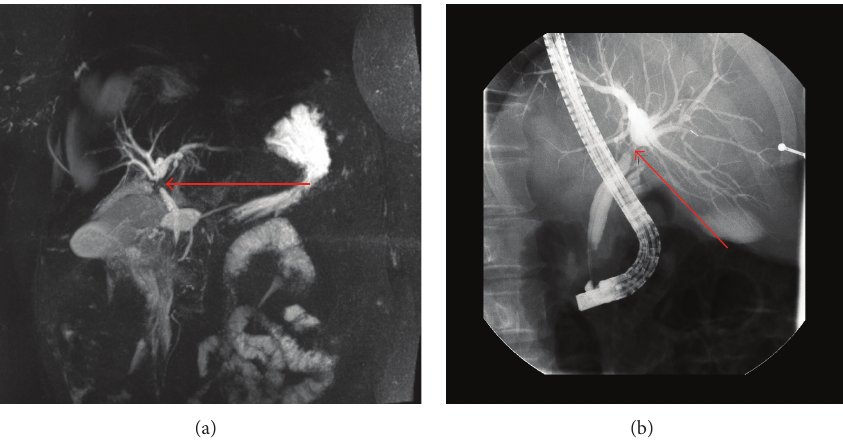
Figure 1: (a) Magnetic resonance cholangiopancreatography (MRCP) and (b) endoscopic retrograde cholangiopancreatography (ERCP) demonstrating stricture and occlusion of the proximal main hepatic duct (marked with red arrow).